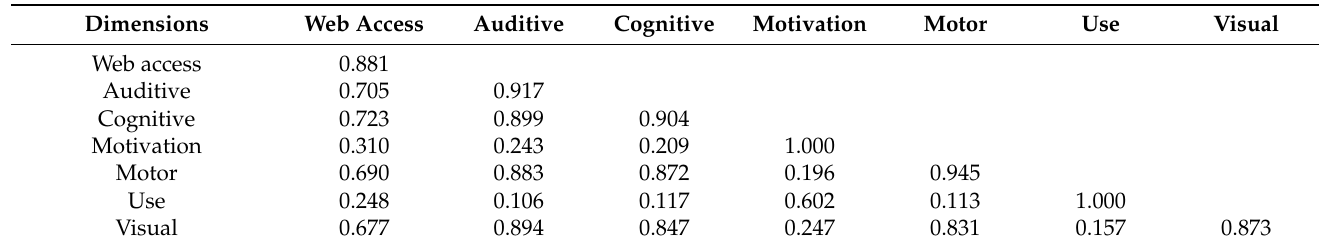
Table 3. Discriminant validity.